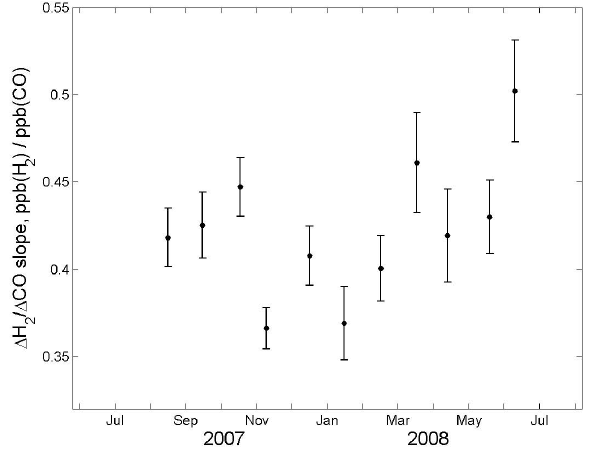
Fig. 8. Monthly variation of mean of 1 H 2 / 1 CO slopes at Kumpula site in Helsinki.